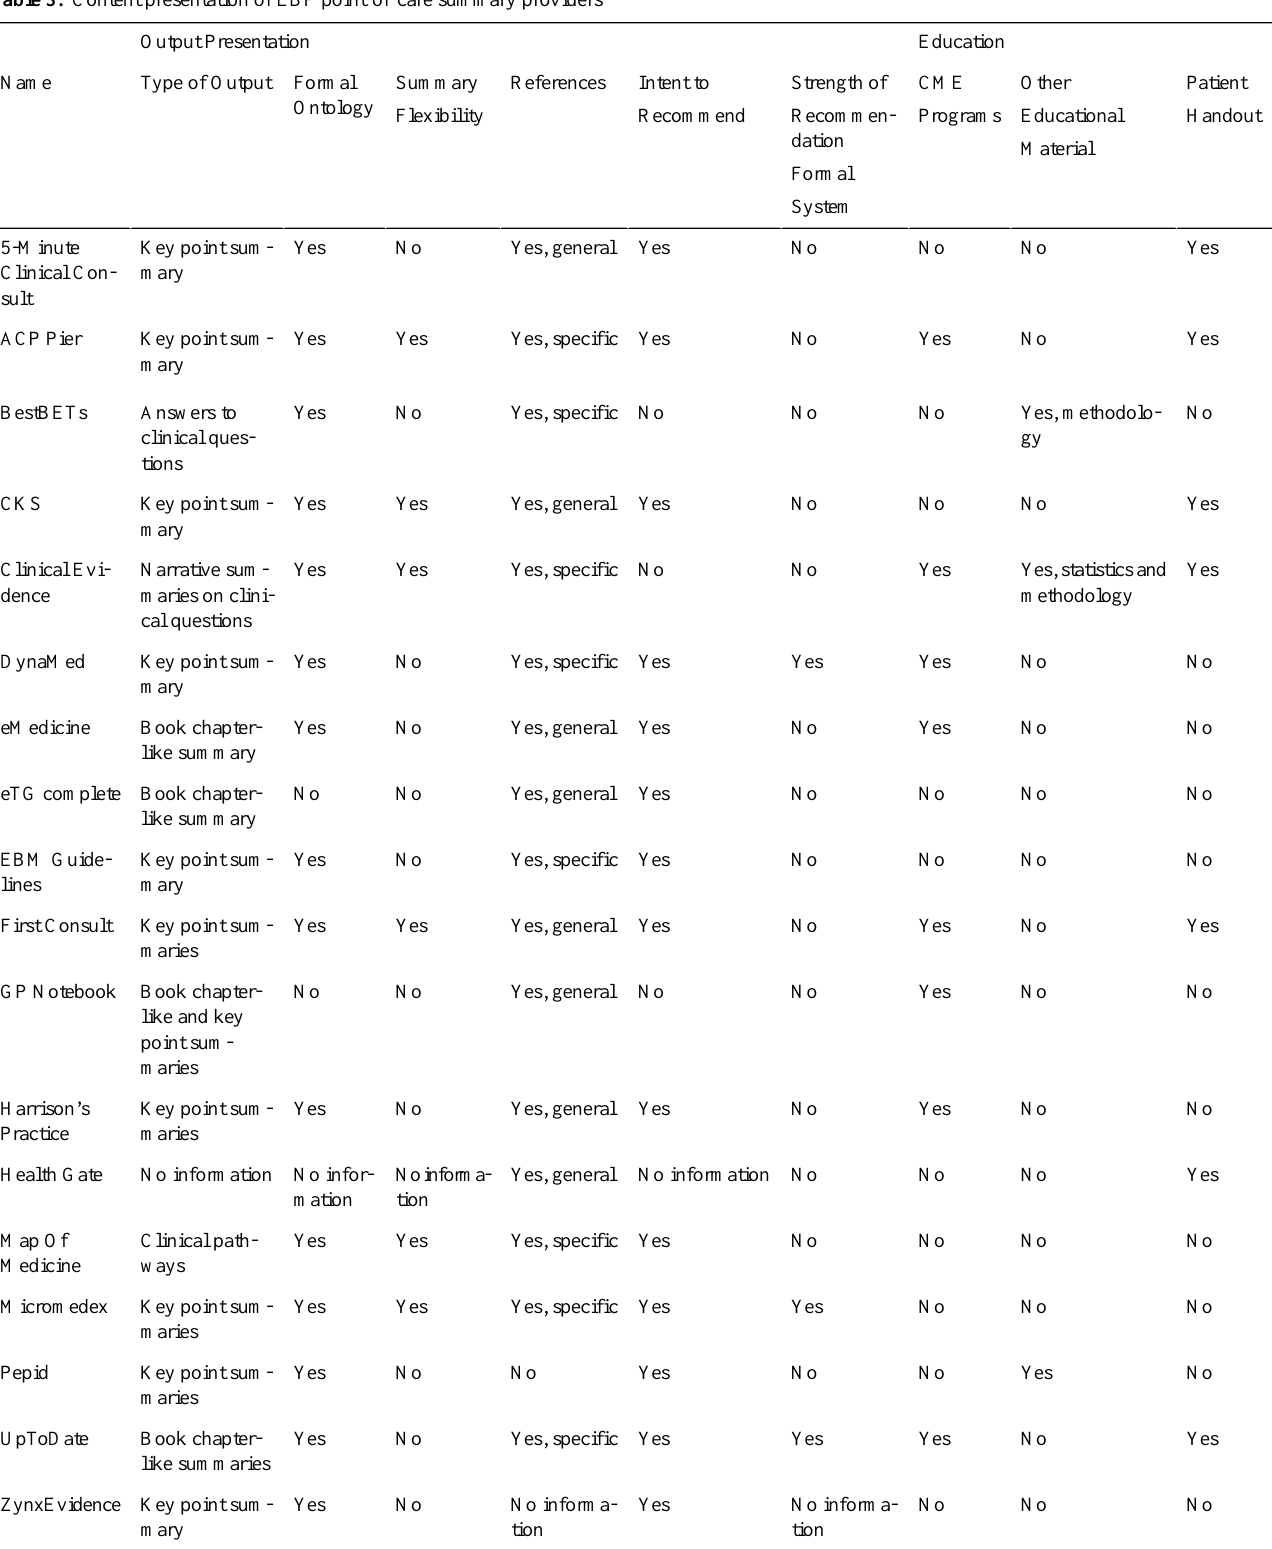
Table 3. Content presentation of EBP point-of-care summary providers